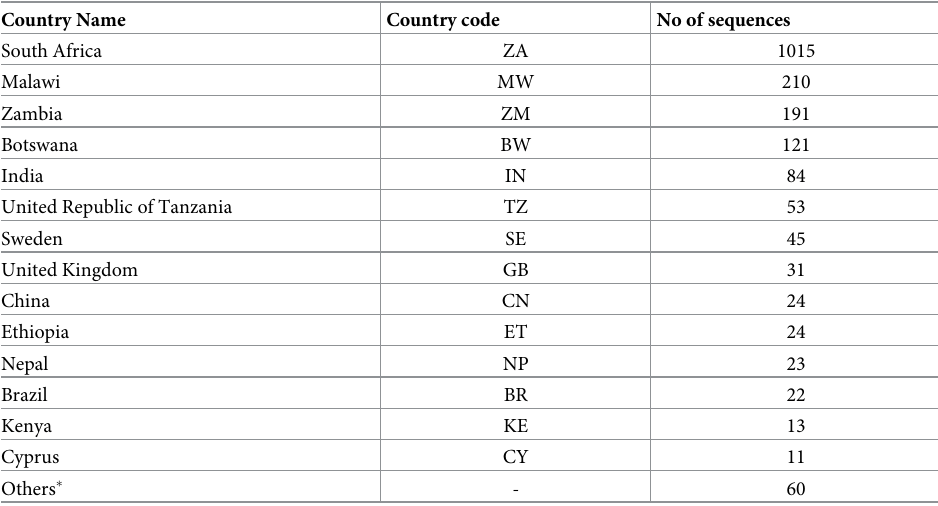
Table 1. Details of country-wise HIV-1 subtype C sequences retrieved from LANL-HIV